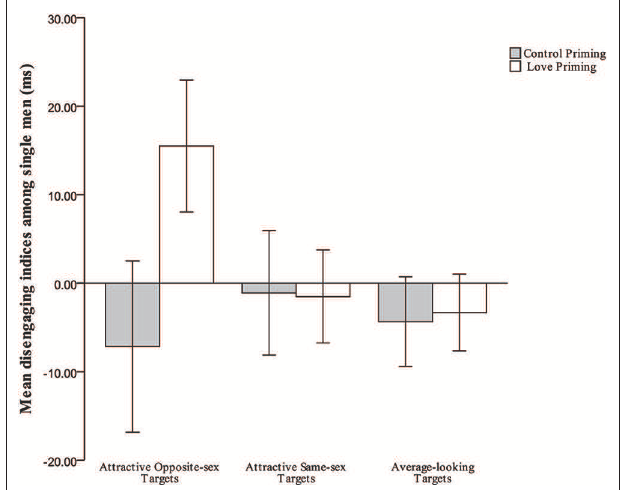
FIGURE 3 | Mean indices of disengagement from attractive women for single and committed men in the love priming and control priming conditions.